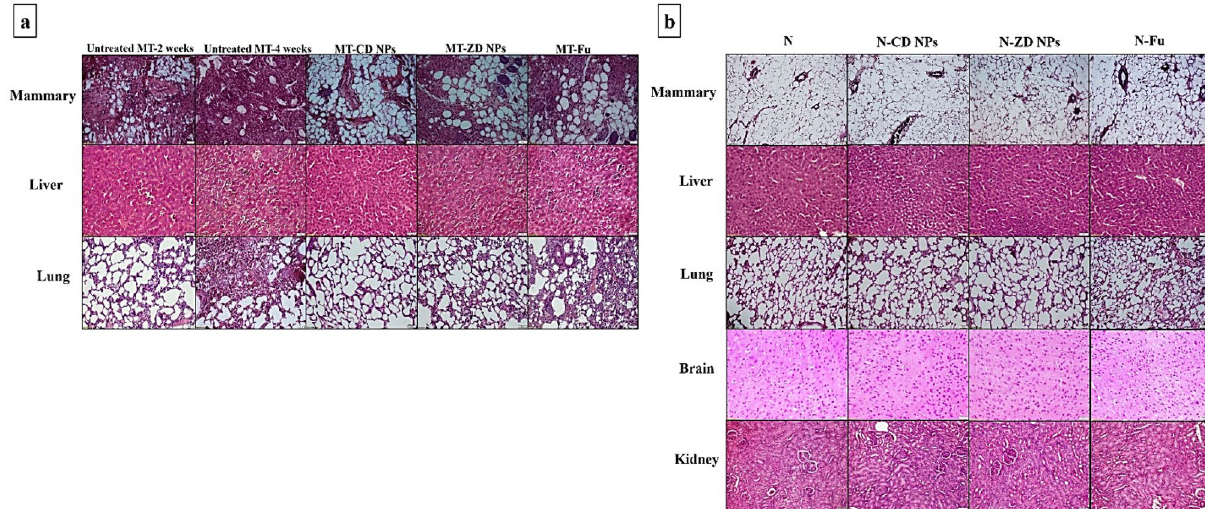
Figure 3. Histological analysis of anti-tumor potential and toxicity on normal tissues. ( a ) Hematoxylin and eosin (H&E)-stained tissue sections of the untreated mammary tumor-bearing mouse group (MT) after 2 weeks and 4 weeks of Ehrlich cell orthotopic injection (showing the mixed ductal and lobular mammary carcinoma with invasion to liver and lung hyperplasia) as well as the treated MT groups. ( b ) H&E-stained tissue sections of healthy untreated group (N) and treated N groups (Magnification, × 200; scale bar, 50 µm).